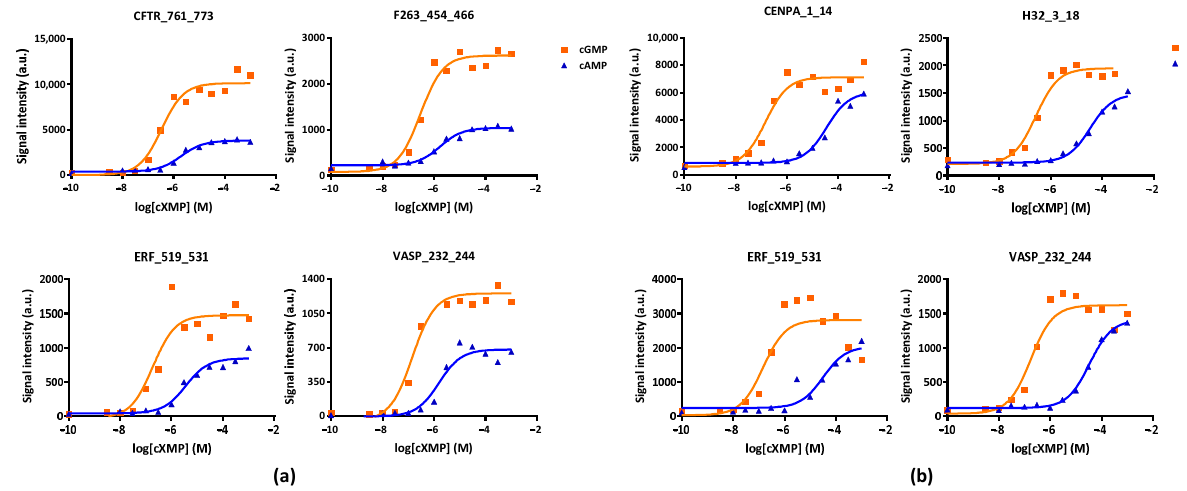
Figure 1. Effect of cGMP and cAMP concentrations on signal intensity of ( a ) PKGI or ( b ) PKGII on selected peptides. The signal intensity is the mean of triplicate measurements.